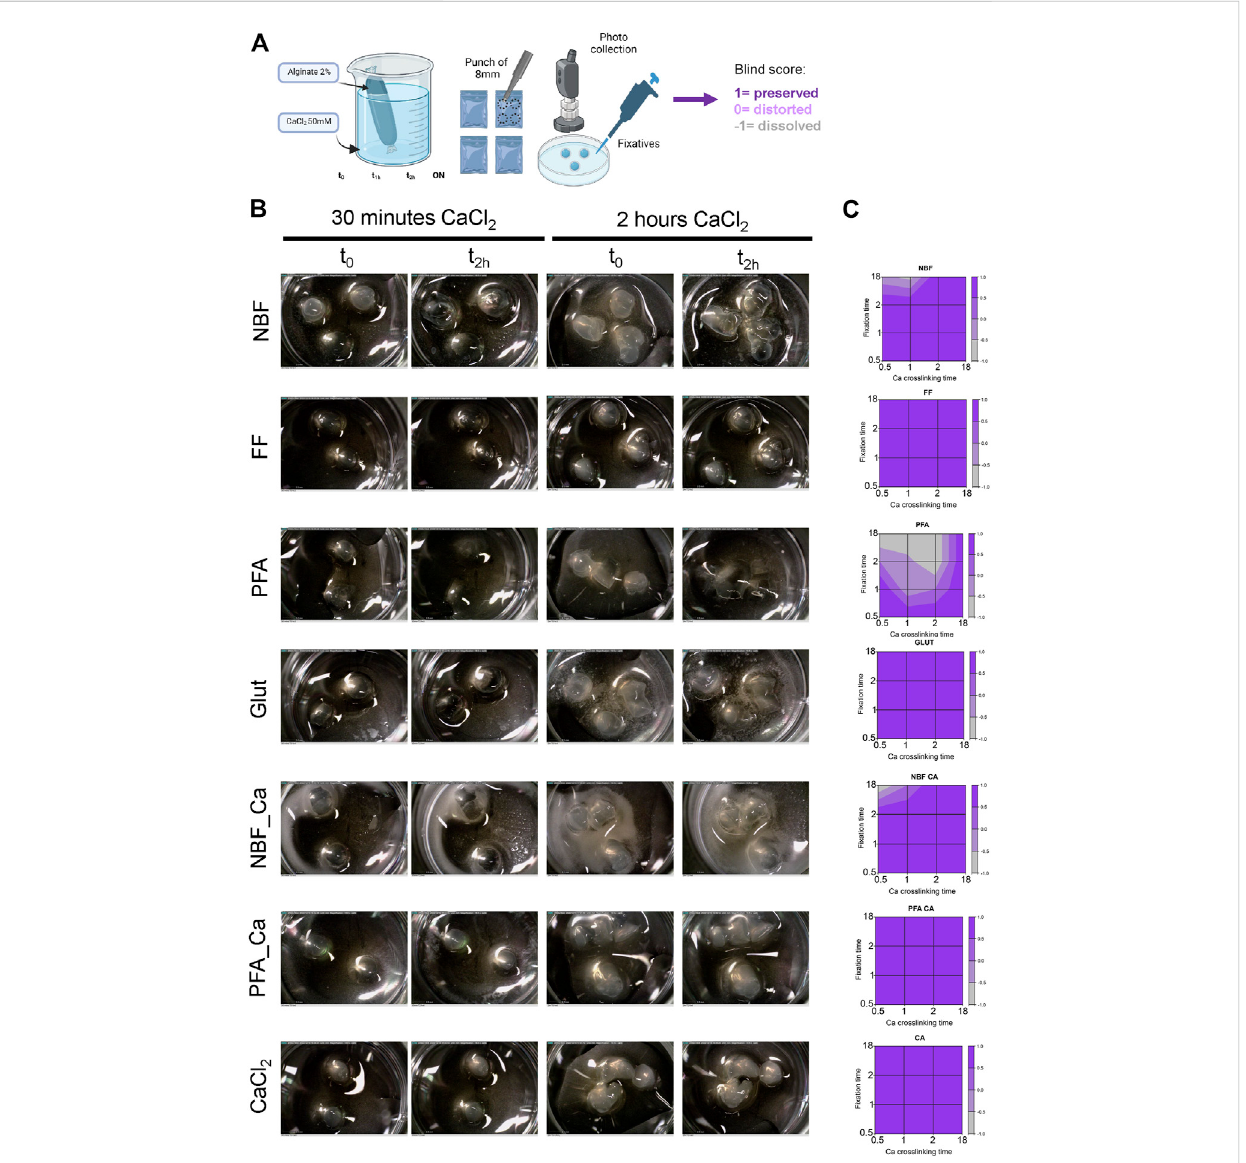
FIGURE 3 Results ofdesignofexperimentsevaluatingtherelationshipbetweencalciumcrosslinkingtime, fi xativeand fi xation time. (A) Experimentaloverview for generating crosslinked calcium alginate based hydrogels via diffusion in dialysis tubing followed by fi xation and blinded scoring. (B) Representative image for 30 min and 2 h of calcium crosslinking time and immediately after fi xation and after 2 h of fi xation for various fi xatives as listed. (C) Contour plots of blinded scoring. Figure 3A made using